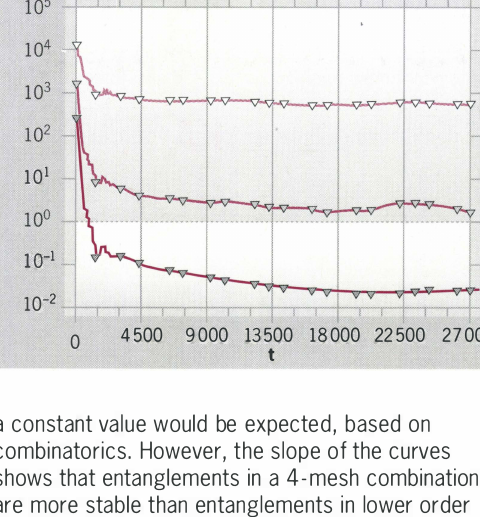
Fig. 9: Relative break down of 2- and 4-meshes in steady shear flow showing the function log#{4-meshes}- 6 log#{2-meshes}